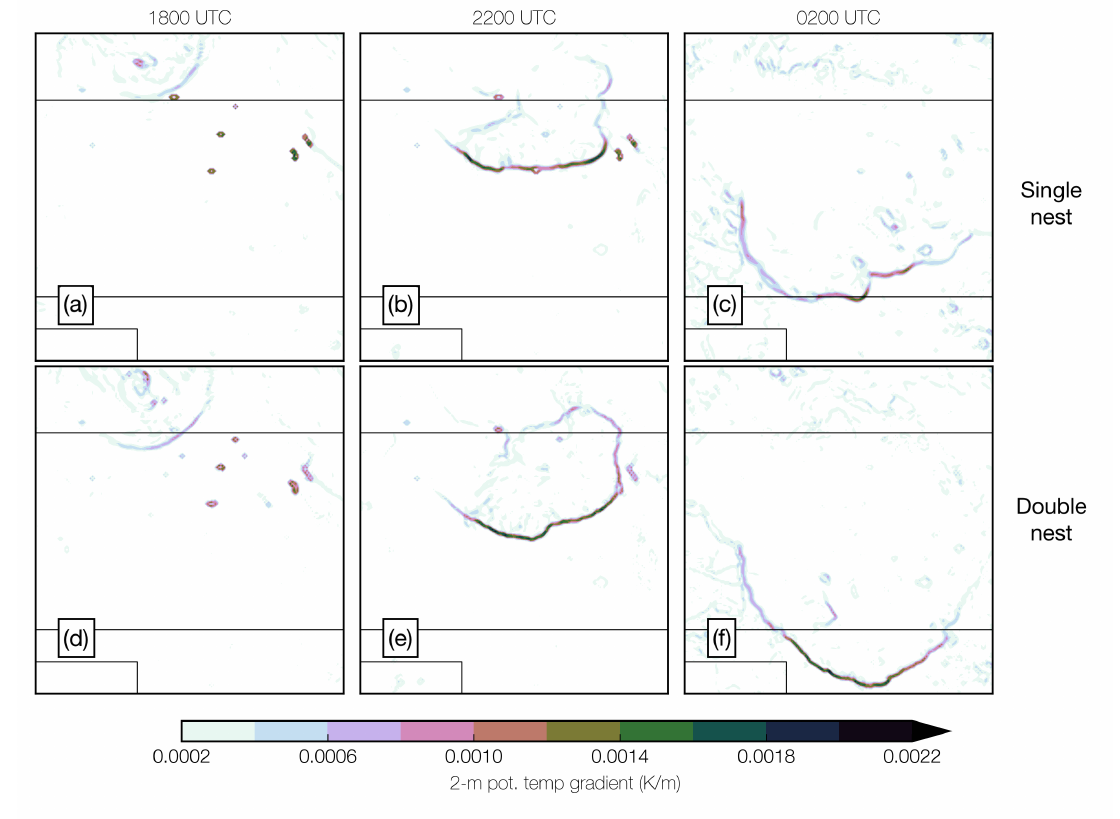
Figure 9. Potential temperature at 2m (color-filled) taken from total absolute SAL median single- (s06; a – c ) and double-nest (s12; d – f ) EPS members. Fields shown at ( a , d ) 18h , ( b , e ) 22h, and ( c , f ) 26h simulation time. States shown in each panel, from north to south, are Nebraska, Kansas, Oklahoma, and (the panhandle of)